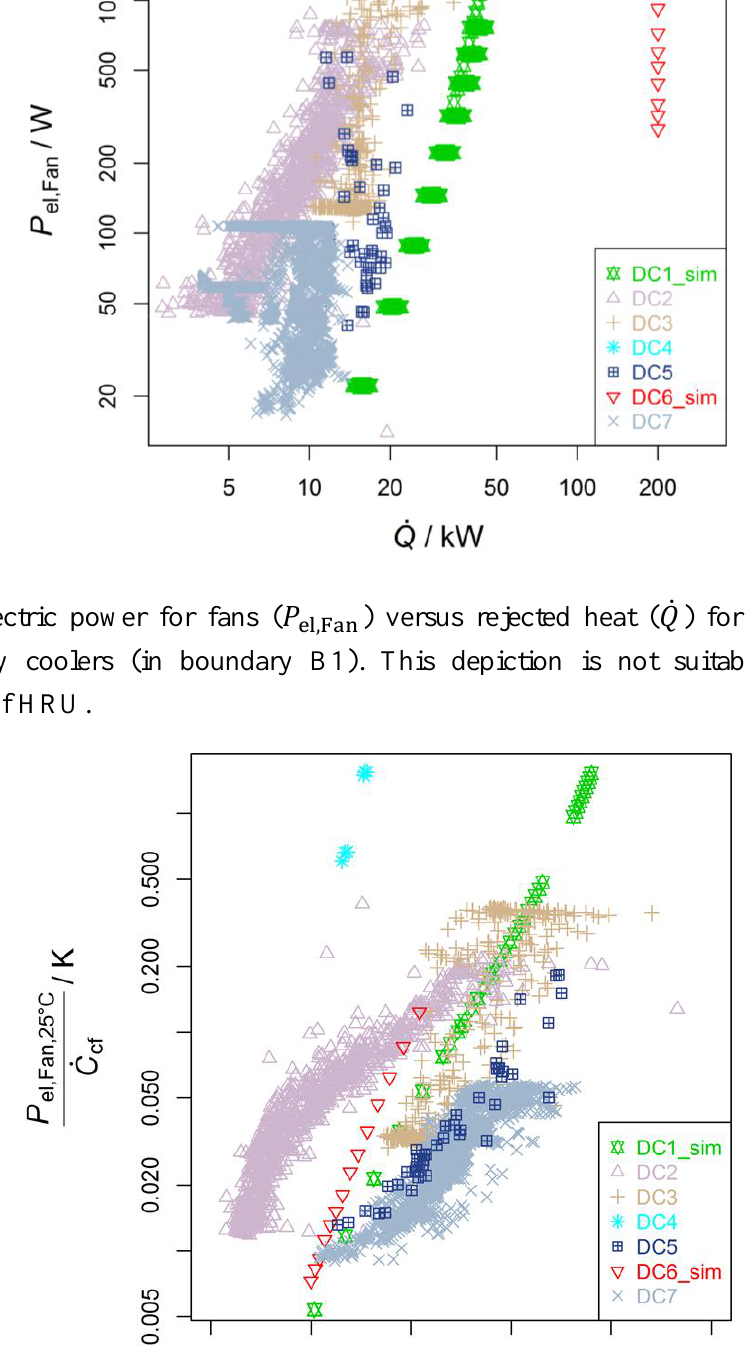
) normalized with cooling fluid el,Fan,25°C ) for simulated and monitored dry cf